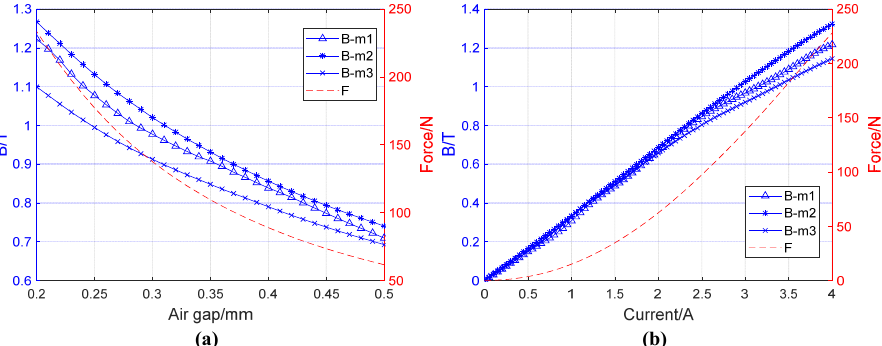
Figure 14. Change the trend of magnetic field intensity at three reference points ( a ) Air gap variation and magnetic field analysis. ( b ) Current variation and magnetic field analysis.